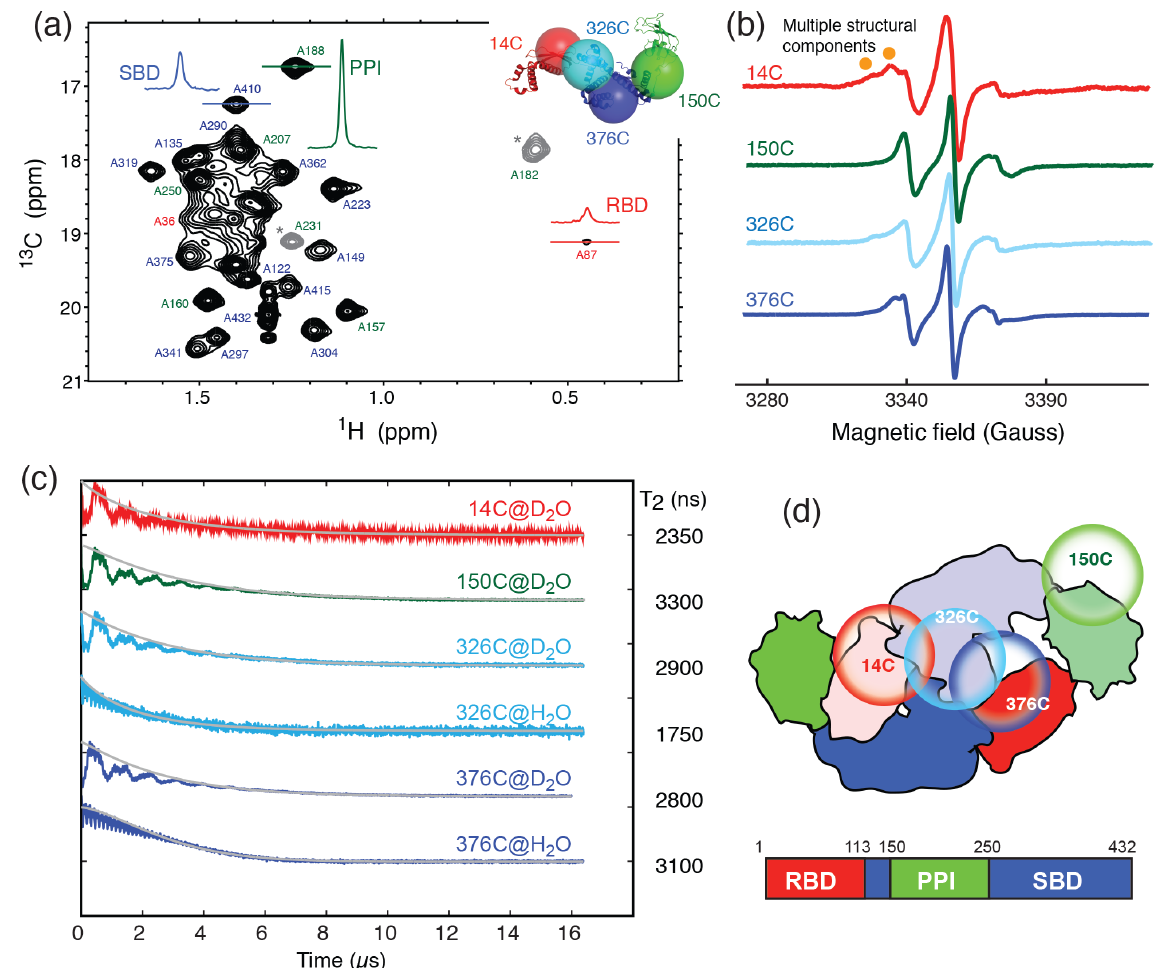
Figure 1. Domain dynamics of dimeric TF in solution. (a) 13 C − 1 H heteronuclear multi-quantum correlation (HMQC) spectrum of U- [ 15 N, 2 H], Ala-[ β − 1 H m / 13 C m ] TF. Selected proton line shapes of cross-peaks originated from the RBD, SBD, and PPI are shown in red, blue, and green, respectively, with their corresponding residue identities indicated. Aliased cross-peaks are shown in grey and labeled with asterisks. Inset: cartoon representation of a monomeric TF (PDB ID: 1w26) with matching coloring for the individual domains. The C α atoms of residues 14, 150, 327, and 376, which were individually mutated into cysteine for MTSL spin labeling, are shown in semitransparent spheres with a radius of 25Å and indicated with their residue identities. (b) CW-ESR spectra of spin-labeled TF variants recorded at 310K as a function of magnetic field. The spectrum of 14C exhibits multiple side peaks (indicated by filled orange circles) that are indicative of multiple structural components. (c) ESE measurements of spin-labeled TF variants. The transverse relaxation times ( T 2 ) of the nitroxide were deduced from the fitting shown by solid grey lines, and their values are indicated on the right. Comparison of the relaxation characteristics of the same samples in H 2 O and D 2 O for 326C and 376C indicated the solvent-exposed nature of the spin labels. (d) Schematic representation of the domain arrangement of dimeric TF, with the locations of the spin labels indicated by open circles. The domain organization of TF is shown below, with the boundaries of individual domains